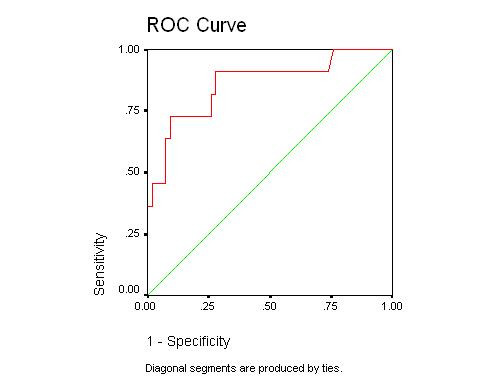
Receiver operating characteristics curve (ROC) of hyaluronate for discrimination of mild (grade 0–8) from significant (grade ≥ 9) inflammation. Hyaluronate at cut off point of 126.43 ngm/ml could differentiate mild from severe inflammation in patients with chronic hepatitis B.